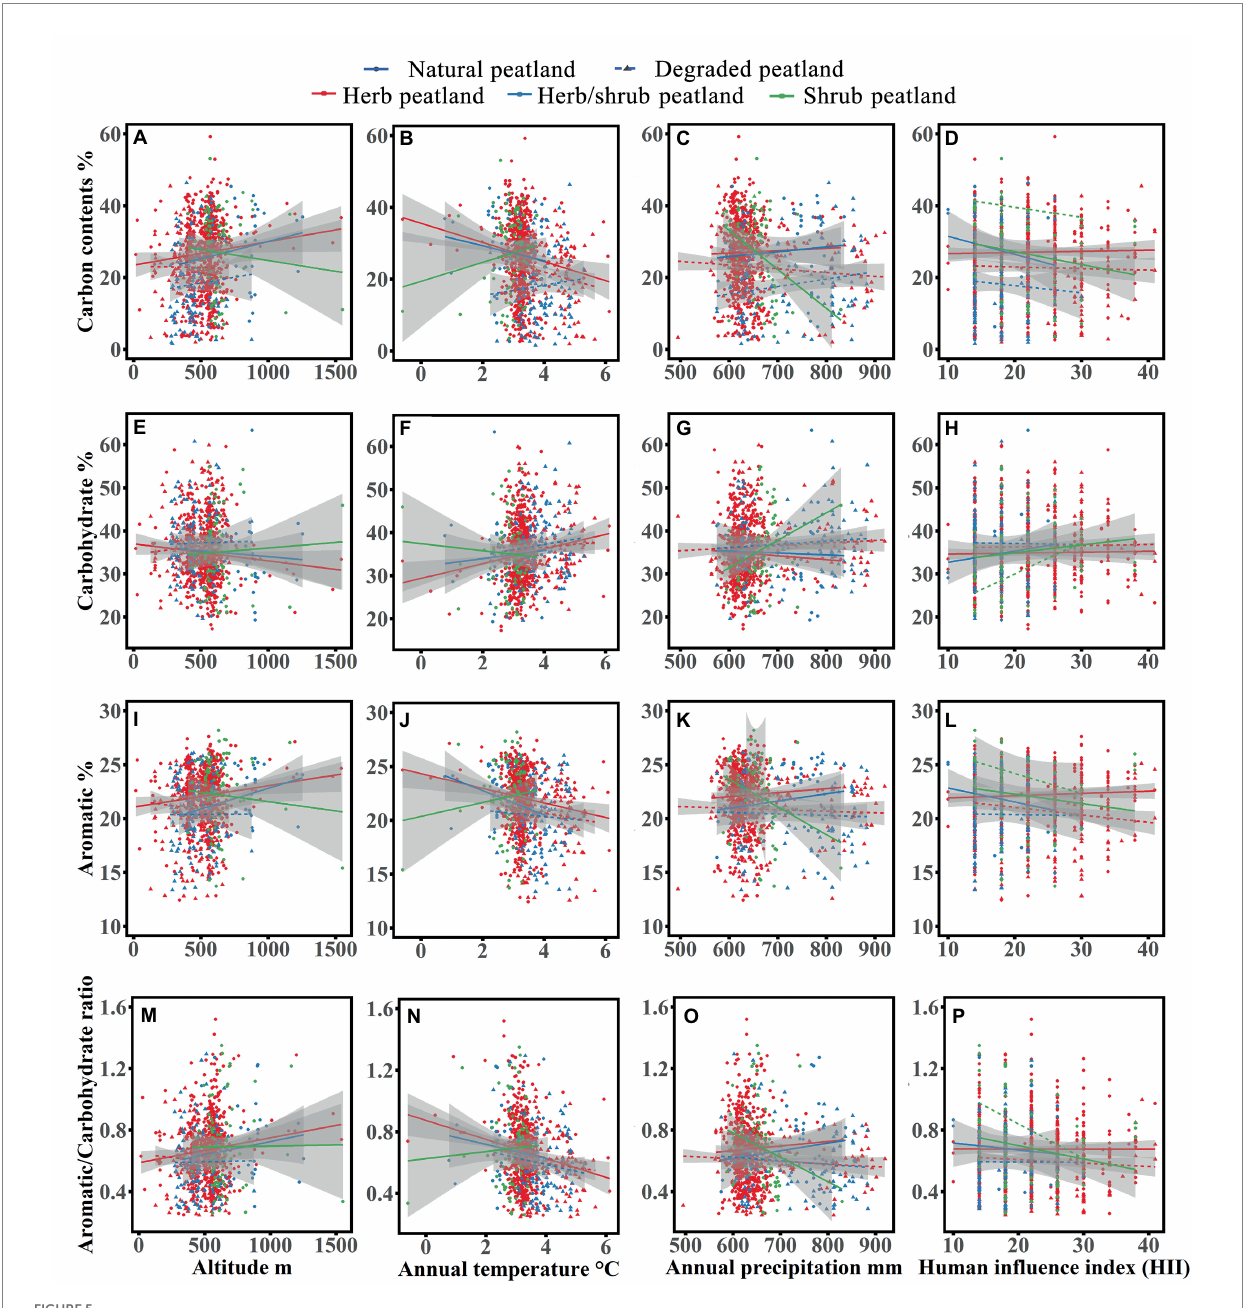
The trend lines were fitted with linear model, and the grey shadows indicate 95% confidence interval of fitted